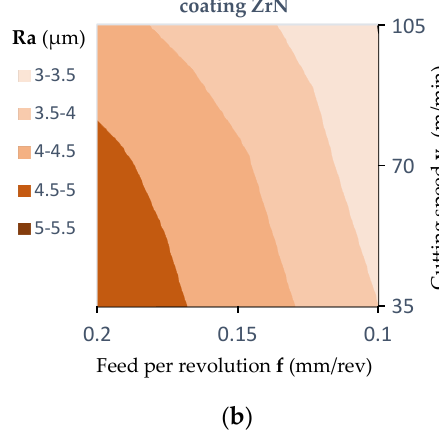
diagrams): ( a ) For a TiAlN coated drill; ( b ) for a ZrN coated drill; ( c ) for an uncoated drill; ( d )